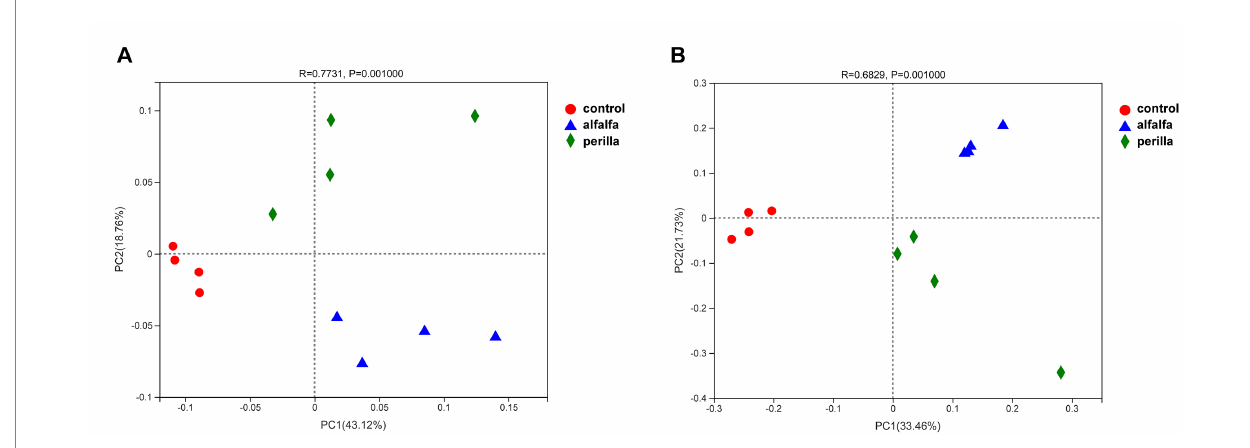
FIGURE 5 PCoA of (A) bacterial and (B) fungal communities in different treatments. Control, no treatment; Alfalfa, alfalfa cultivation; Perilla, perilla